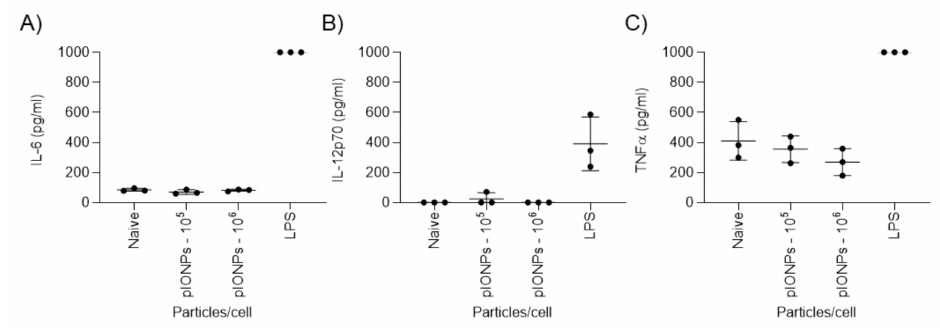
Figure 3. Analysis of cytokine production by BMDCs after 24-h incubation with pIONPs. Inflammatory cytokine levels, ( A ) IL-6, ( B ) IL-12p70 and ( C ) TNF- α , in BMDC supernatants were measured by ELISA. The LPS levels were above the highest standard for IL-6 ( A ) and TNF α ( C ) and were set to 1000 pg / mL. The naïve and 10 6 pIONPs per cell were below the standard curve for IL12p70 ( B ) and were set to 0 pg /